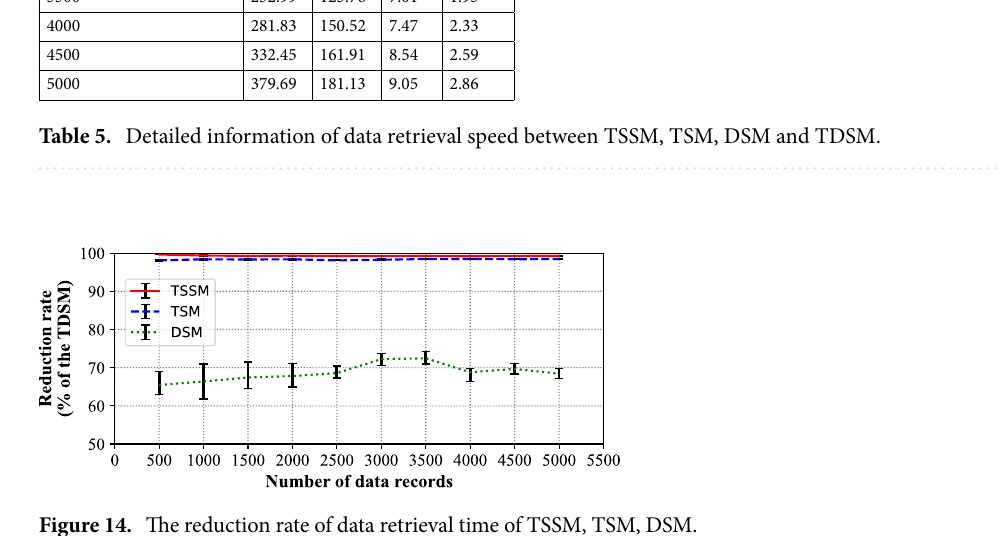
Figure 14. The reduction rate of data retrieval time of TSSM, TSM,